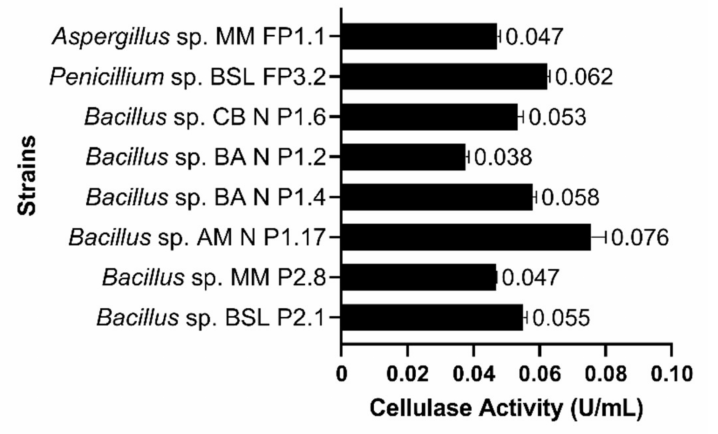
Figure 6. Cellulase activities, expressed in units per mL, in the culture supernatant. The results are presented as averages of three replicates; error bars represent the standard deviation of the mean.